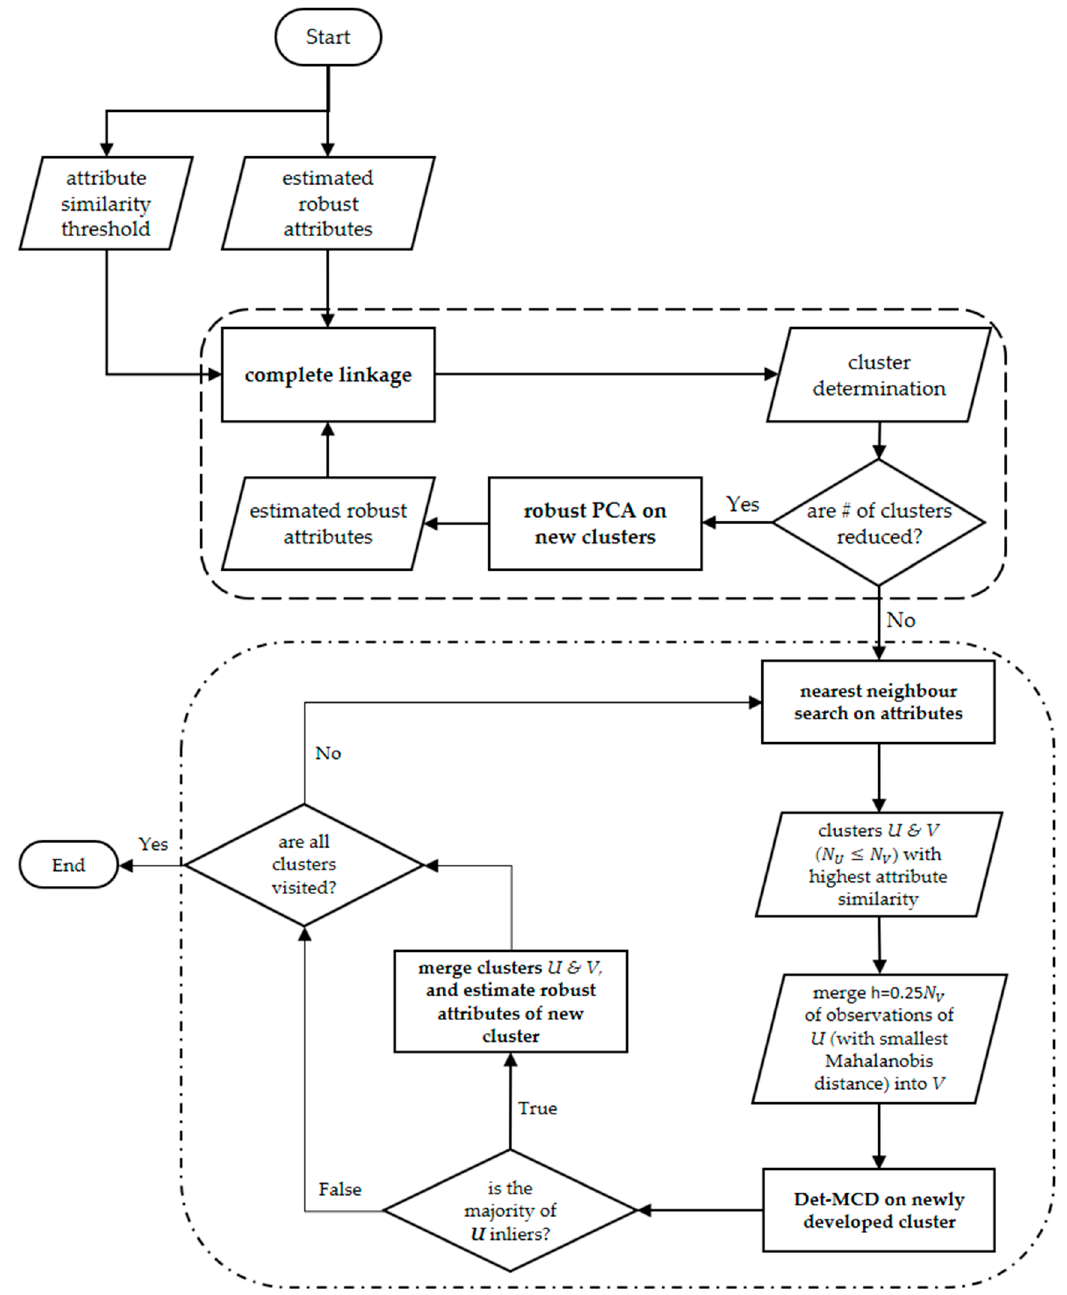
Figure 5. Robust complete linkage algorithm for robust clustering of planar and linear surfaces.